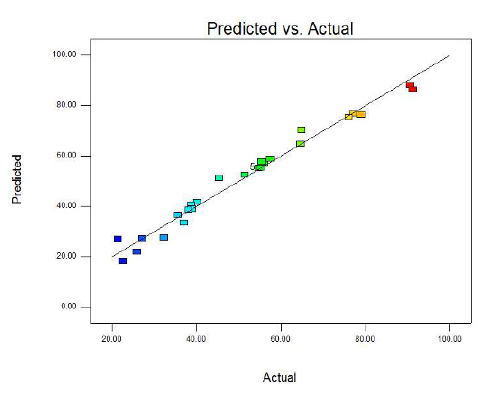
Figure 2. Plot of predicted versus actual value of response output for solar induced photocatalytic decolourization of dye ef- fluent (Predicted using response surface